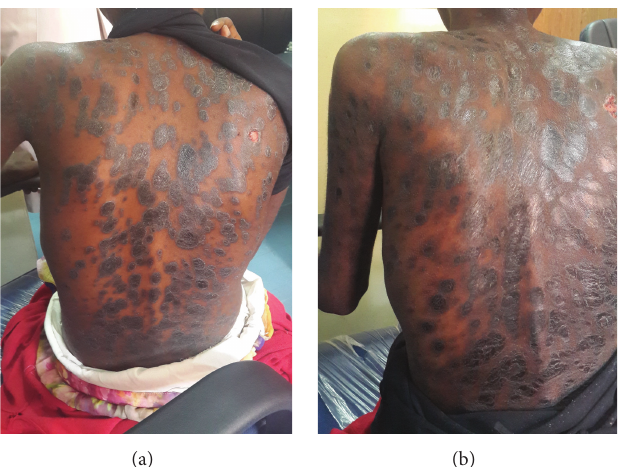
Figure 1: (a) Hyperpigmented plaques (elevated lesions) seen before commencement of treatment; (b) shiny hyperpigmented patches (flat lesions) of postinflammatory hyperpigmentation seen after 3 months of antifungal treatment.